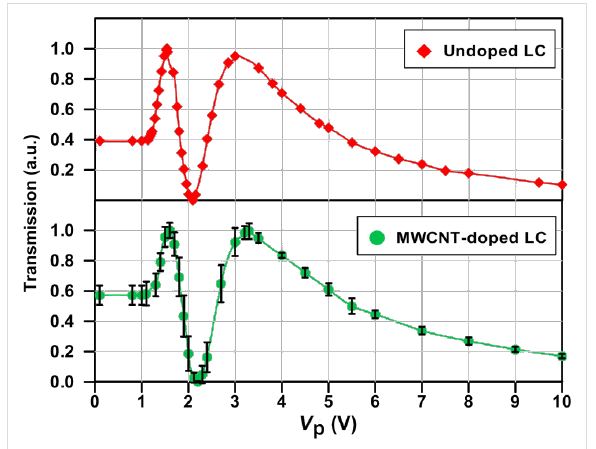
Figure 3: Light transmission response of undoped (top) and MWCNT- doped (bottom) cells at 543 nm. The bottom plot is an average of three